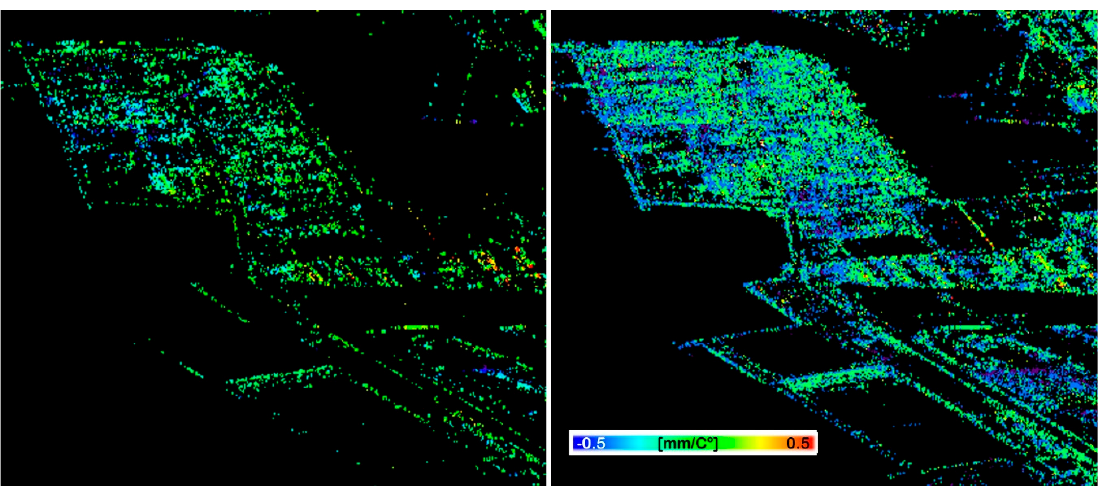
Figure 6. Thermal expansion parameter (THER) maps by PSI ( Left ) and by TomoSAR ( Right ).